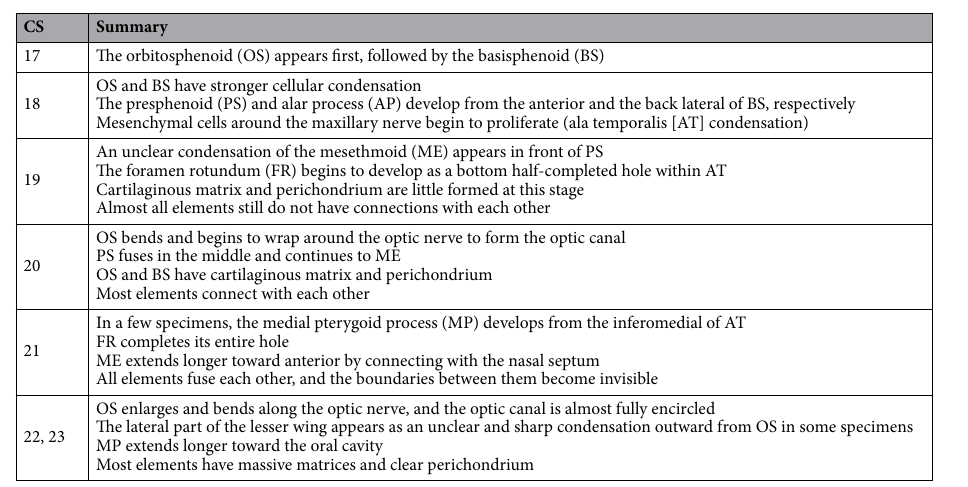
Table 3. Summary of the developmental process of the sphenoid during the embryonic period.